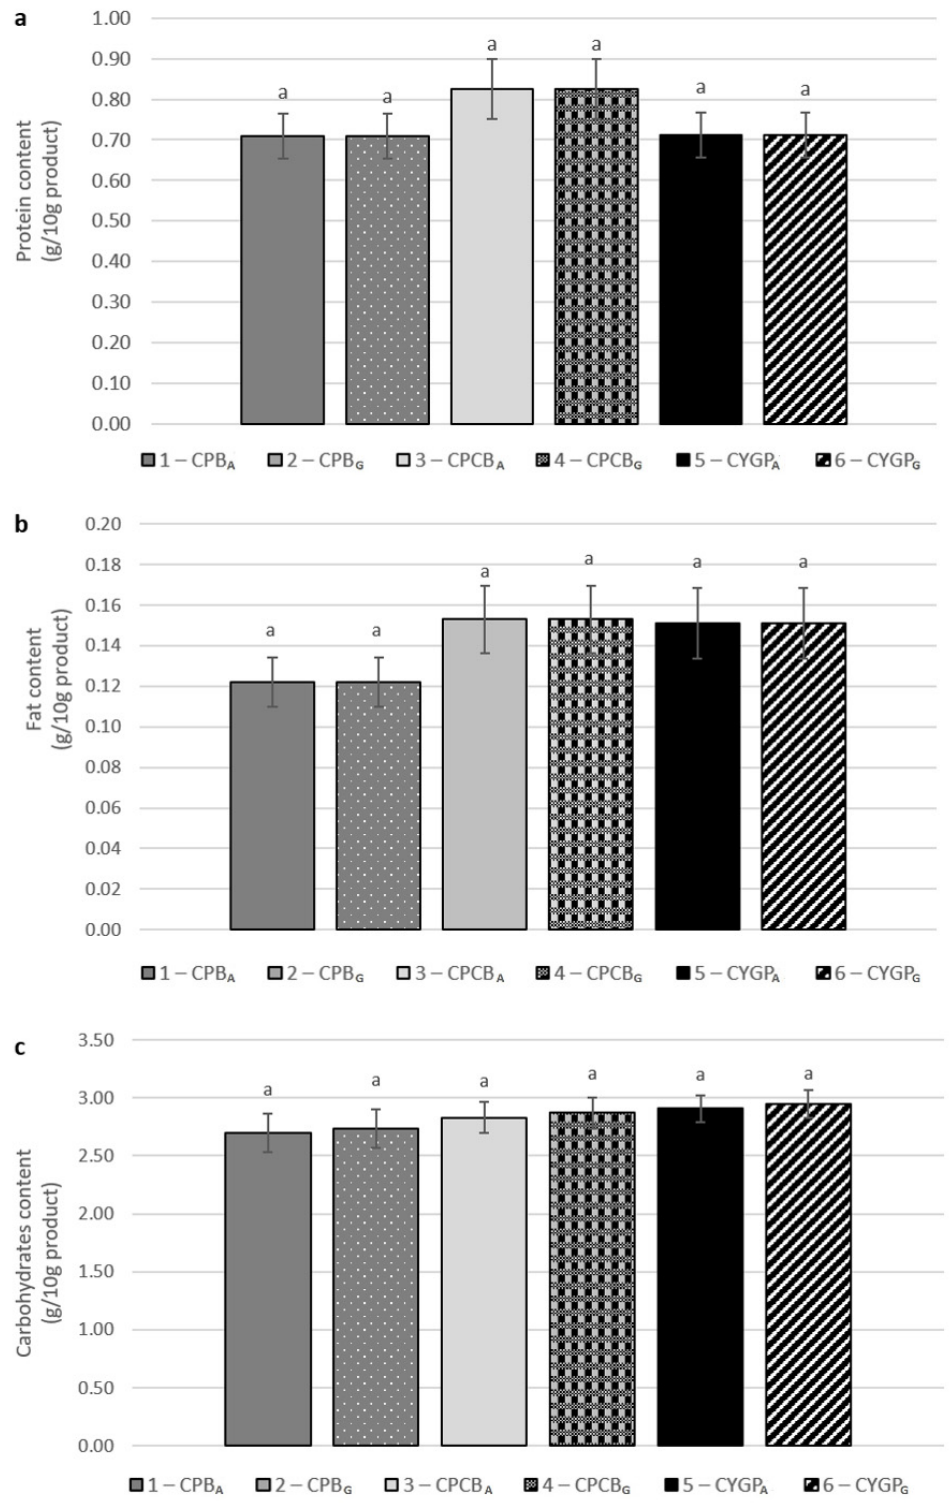
Figure 2. Average nutritional value of freeze-dried vegetable-based products produced with hydrocolloids: ( a ) protein; ( b ) fat; and ( c ) carbohydrates. The same letters (a) in individual columns indicate the absence of a statistically significant difference between the samples (significance level 0.05). Designations displayed in Table 1. Index (A) next to the formulations symbol—formulations with sodium alginate and calcium lactate, index (G) next to the formulations symbol—formulations with the mixture of locust bean gum and xanthan gum.